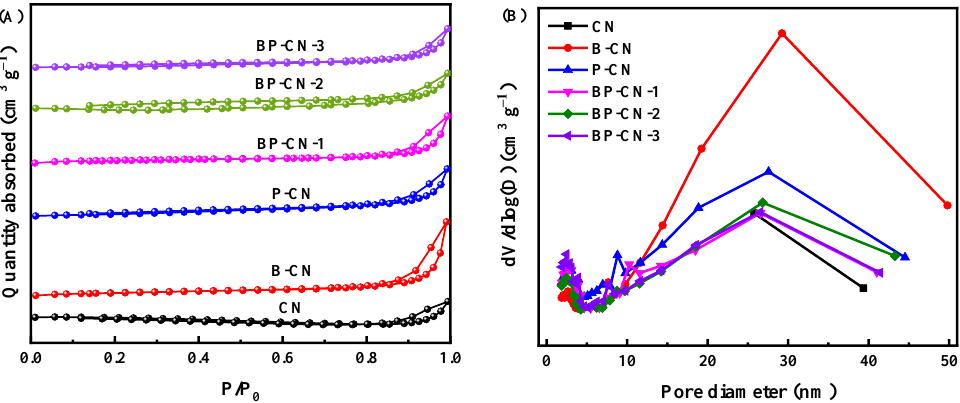
Figure 4. N 2 adsorption–desorption isotherms of the synthesized catalysts. ( A ) N 2 adsorption–desorption isotherms; ( B ) pore size distribution. Table 1. S BET , BJH average pore diameter and B, P mass fraction of catalysts.